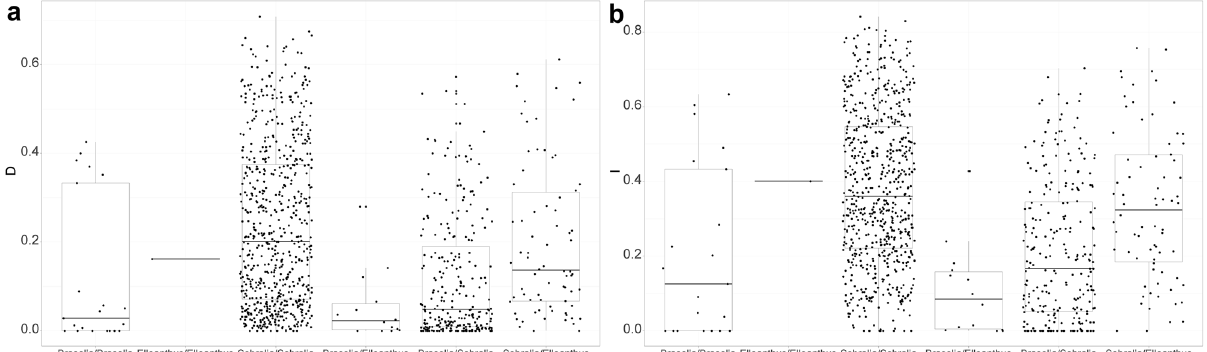
Figure 2. Niche overlap illustrated by ( a ) Schoener’s D 45 and ( b ) I statistic 46 . Boxplots show the pairwise niche overlap between species belonging to the following groups: within each genus ( Brasolia , Elleanthus , Sobralia ) and between genera ( Brasolia and Elleanthus , Brasolia and Sobralia , Sobralia and Elleanthus ). The niche overlap value for each pair of species within a given group is represented by a